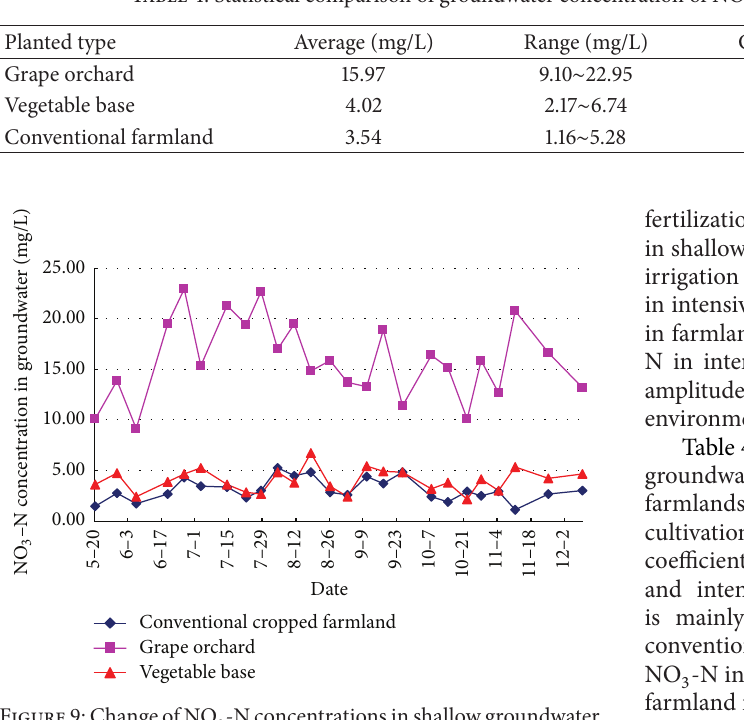
Table 4: Statistical comparison of groundwater concentration of NO